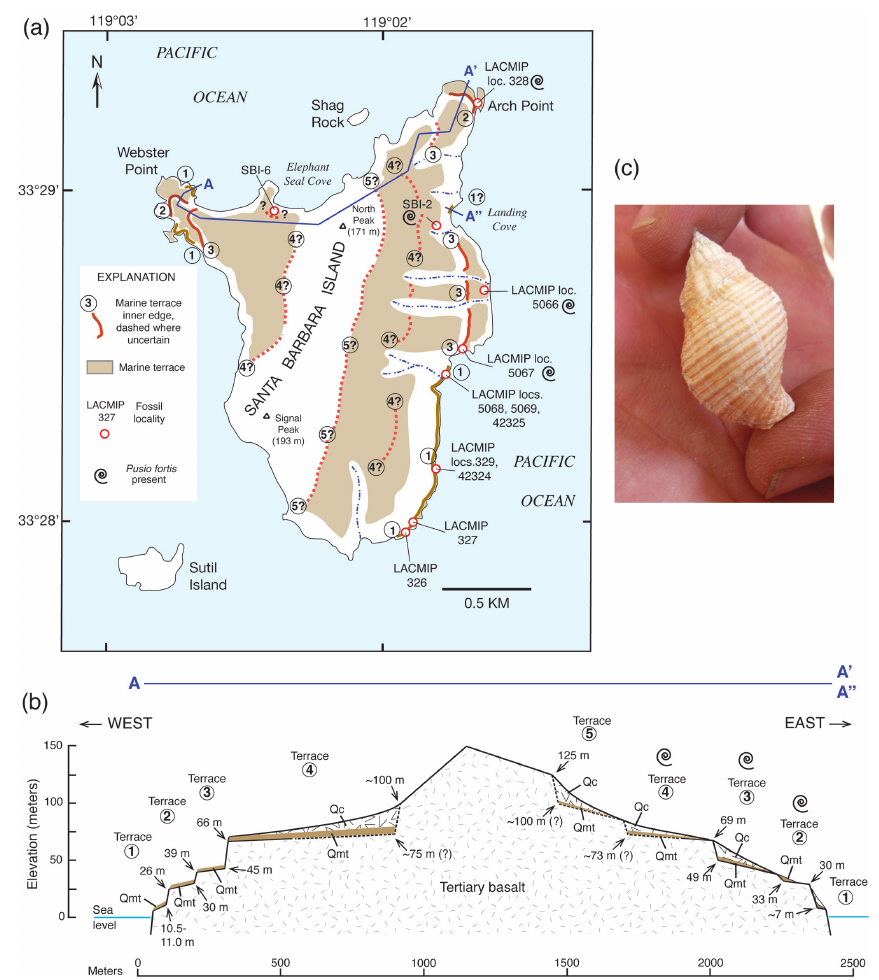
Figure 38. Use of an extinct species as a biostratigraphic marker. (a) Map of marine terraces and fossil localities on Santa Barbara Island, California (from Muhs and Groves, 2018), along with (b) topographic profile of terraces (location shown in a ). Also shown in both (a) and (b) are terrace deposits that host the extinct fossil gastropod Pusio fortis (formerly Calicantharus fortis ), shown in (c) . Note that in (a) and (b) , this taxon is not found on terrace 1, whose deposits contain a mix of fossils dating to MIS 5e and 5c, but the species is found on higher terraces, indicating that it likely became extinct before MIS 5e. Photograph in (c) is from 69m high terrace deposits on San Miguel Island and is by Daniel R.